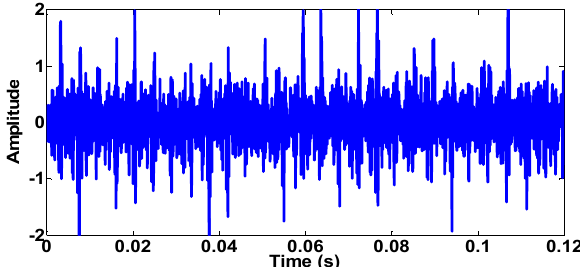
Figure 9. Time-domain waveform of a serious outer race fault in bearing 1. Figure 9. Time ‐ domain waveform of a serious outer race fault in bearing 1. Figure 9. Time ‐ domain waveform of a serious outer race fault in bearing 1.